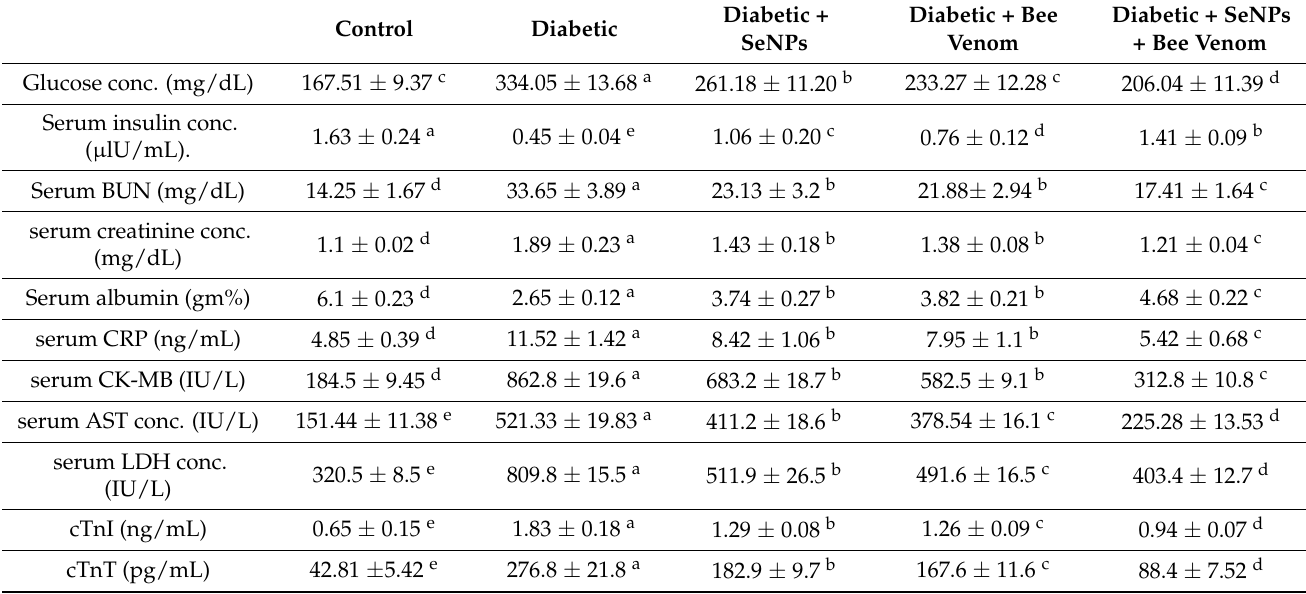
Table 2. The effect of SeNPs and/or BV on biochemical parameters related to heart and kidneys of normal and STZ-diabetic